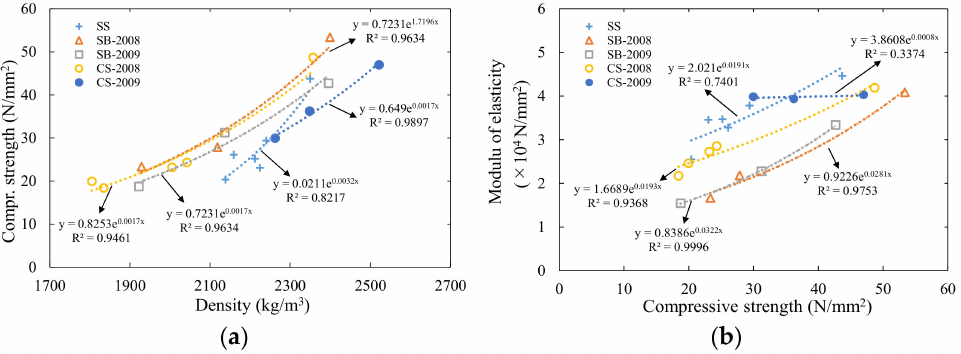
Figure 24. The relationship between the density, compressive strength, and elastic